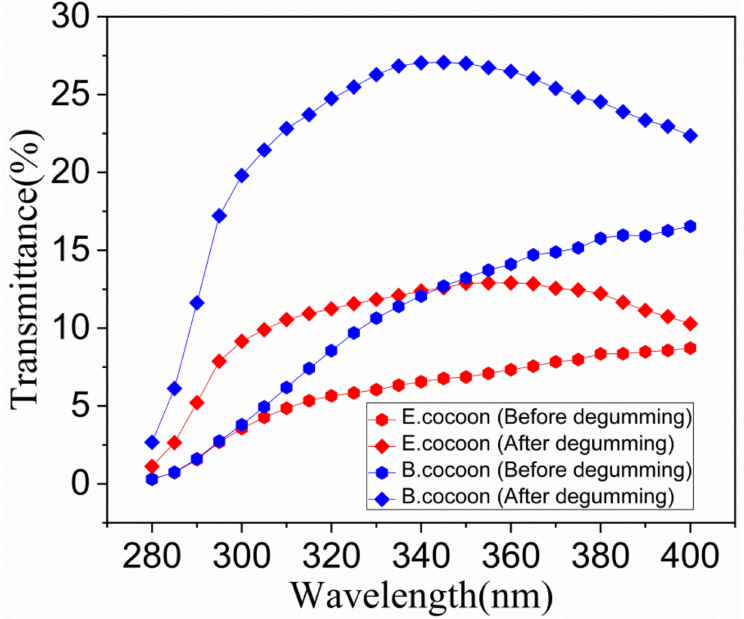
Figure 13. The anti-UV performance of the E and B cocoons before and after